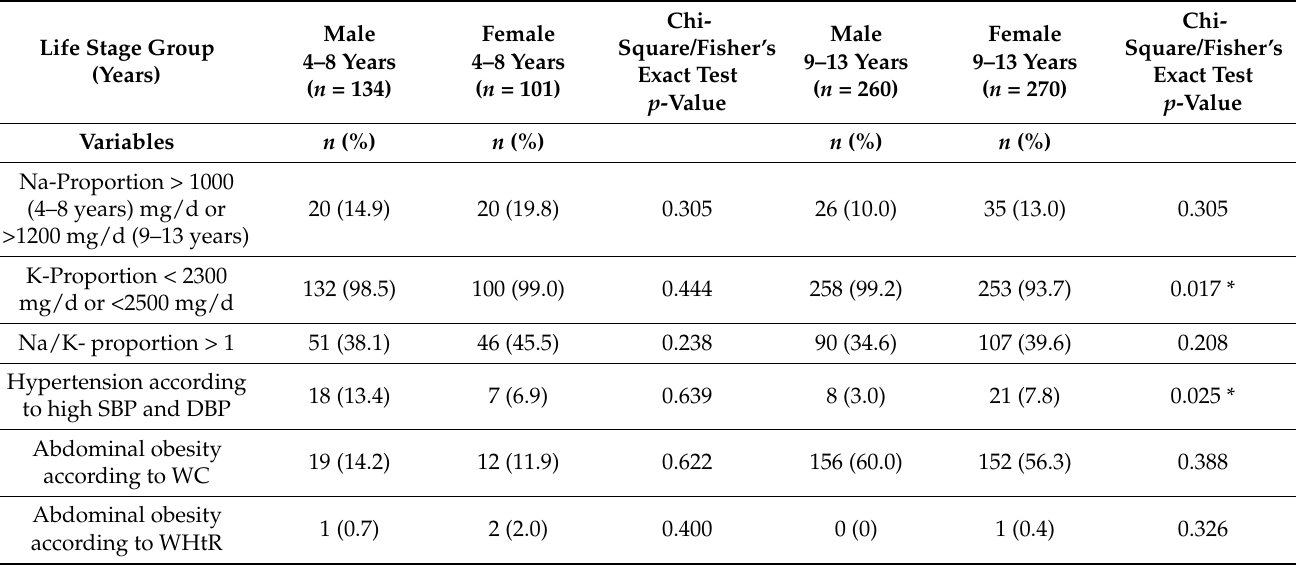
Table 3. The prevalence of sodium, potassium intake, sodium/potassium ratio, hypertension and abdominal obesity according to WC and